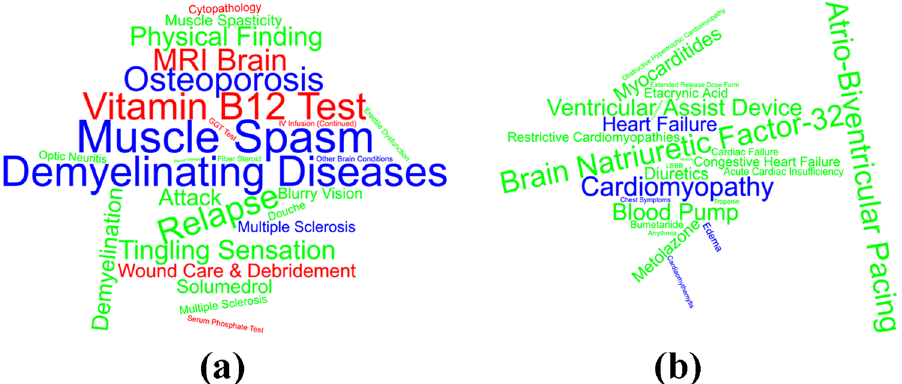
Figure 2. Feature word clouds for ( a ) MS relapse and ( b ) HF onset using the product of SAMGEP’s feature weights and the empirical standard deviations of corresponding features. See the “Evaluation metrics” subsection of the “Methods” for details.